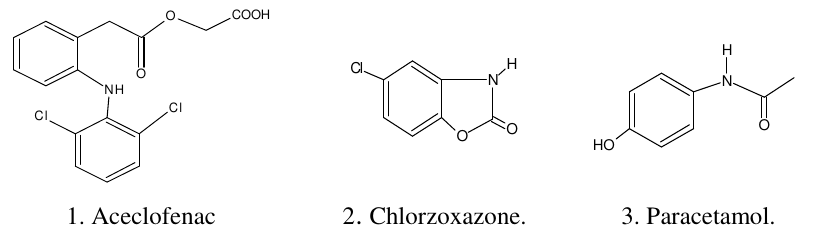
Figure 1. The structural